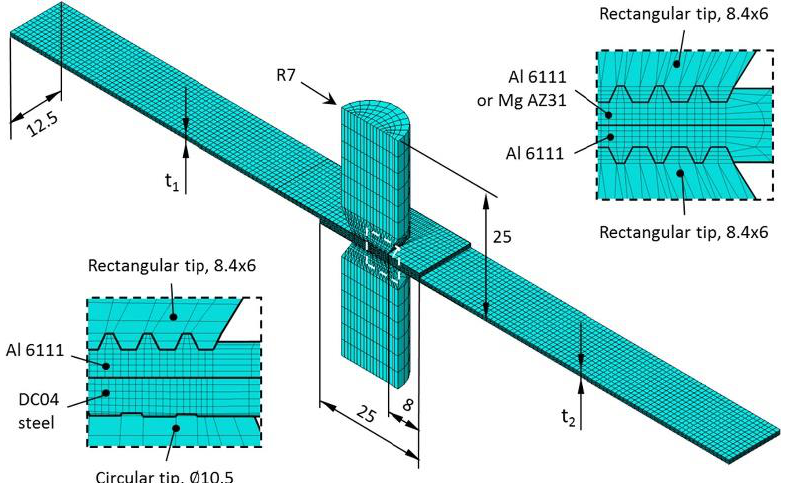
Figure 28. 3-D finite element model [51].